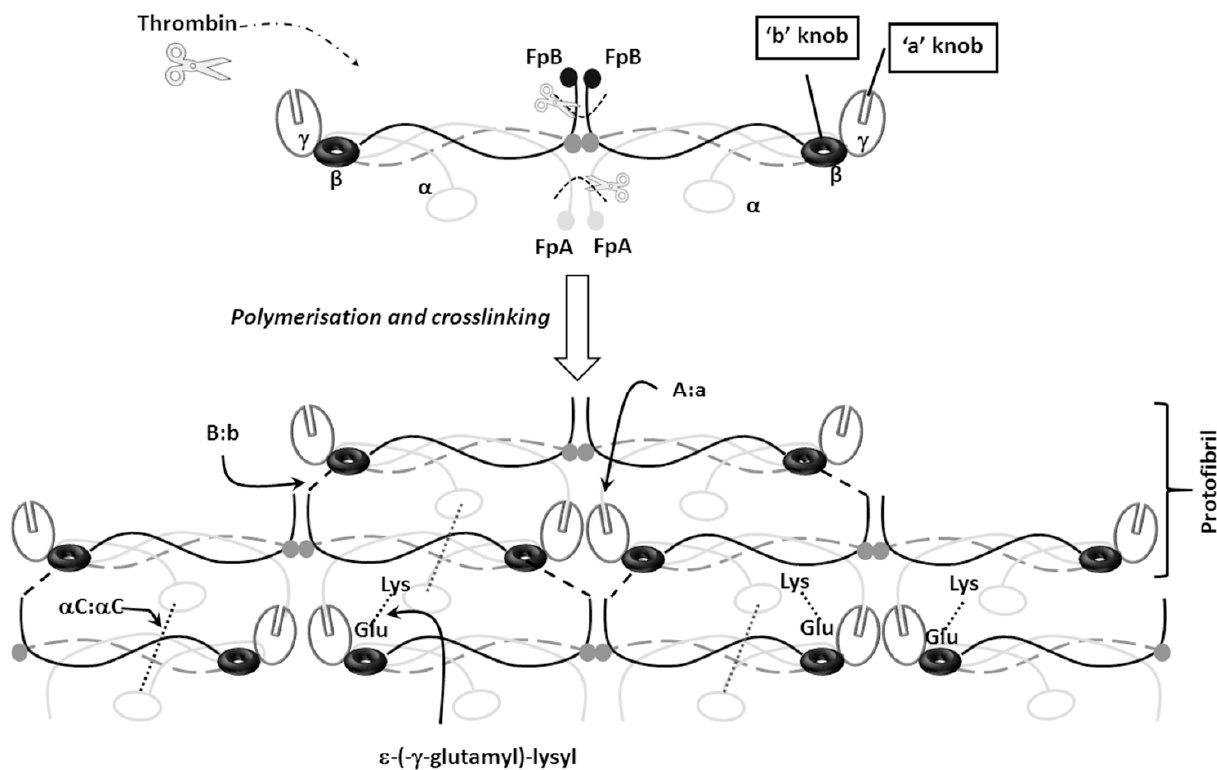
Figure 2. Fibrin polymerisation. Thrombin mediated cleavage of fibrinopeptides FpA and FpB initiates fibrinogen conversion into fibrin. Cleavage of FpA and FpB from the N-termini of A α and B β respectively exposes knob ‘A’ and ‘B’, which in turn interact with complementary pockets ‘a’ and ‘b’ located on the γ - and β - nodules on a neighbouring fibrin monomer. FpB cleavage occurs at slower rate compared to FpA, and this is followed by the release of the α C domains allowing α C: α C interactions and lateral aggregation. Activation of FXIII by thrombin facilitates FXIII-mediated interactions between glutamate (Glu) residues on the γ chain and lysine (Lys) residues on the A α chain through ε -( γ -glutamyl)-lysyl crosslinks.